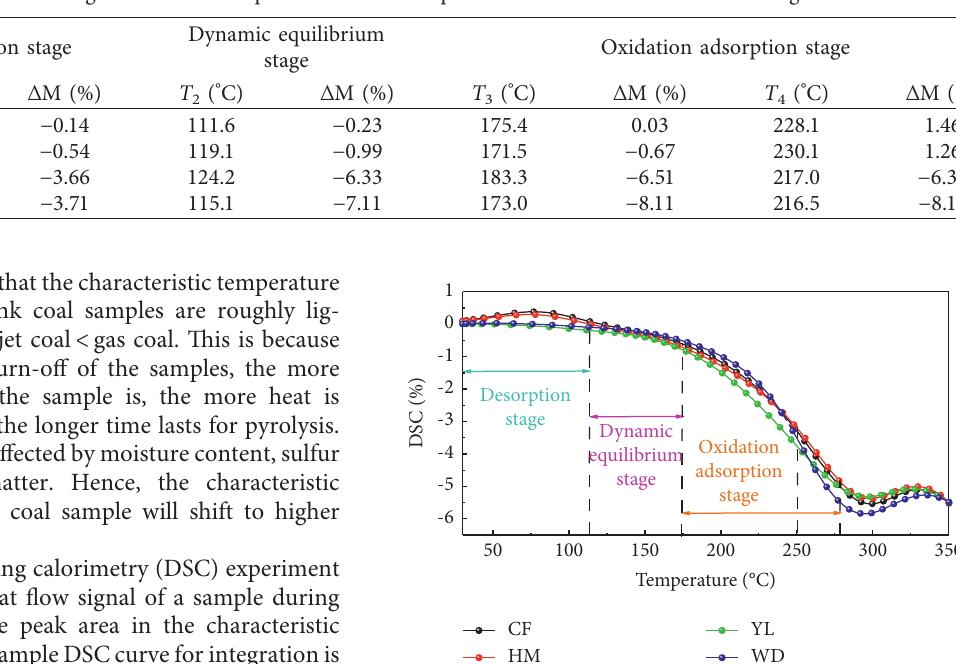
Figure 2: TG curves and stage division of the coal samples. Table 2: Mass change of the coal samples at different temperature-rise rates and at different stages.